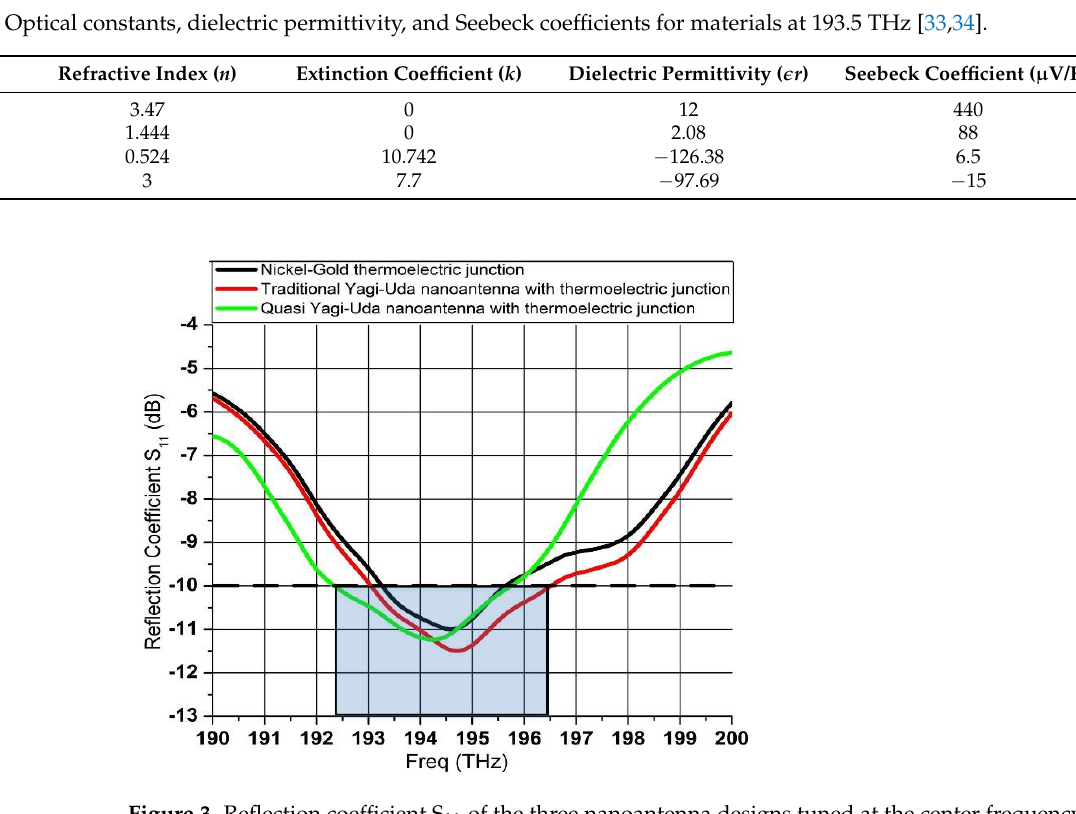
Figure 3. Reflection coefficient S 11 of the three nanoantenna designs tuned at the center frequency of 193.5 THz (simulation). Table 1. Optical constants, dielectric permittivity, and Seebeck coefficients for materials at 193.5 THz [33,34].